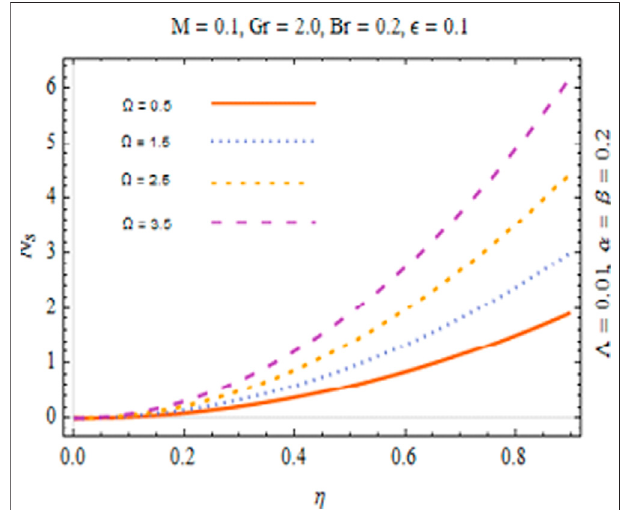
FIGURE 15 | Behavior of Entropy generation number against magnetic parameter.